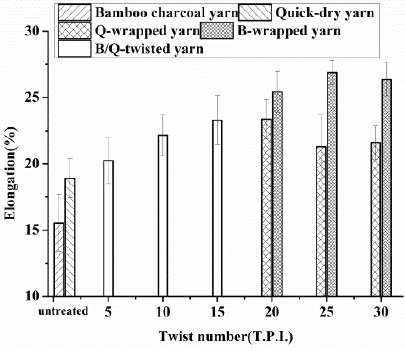
Figure 5. Elongation of functional composite yarns in relation to the administration of a wrapping/ twisting process as well as the t wist n umber. The error bar indicates the SD.